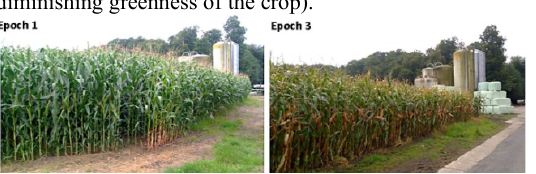
Figure 17. Showing crop greenness between epoch 1 and 3